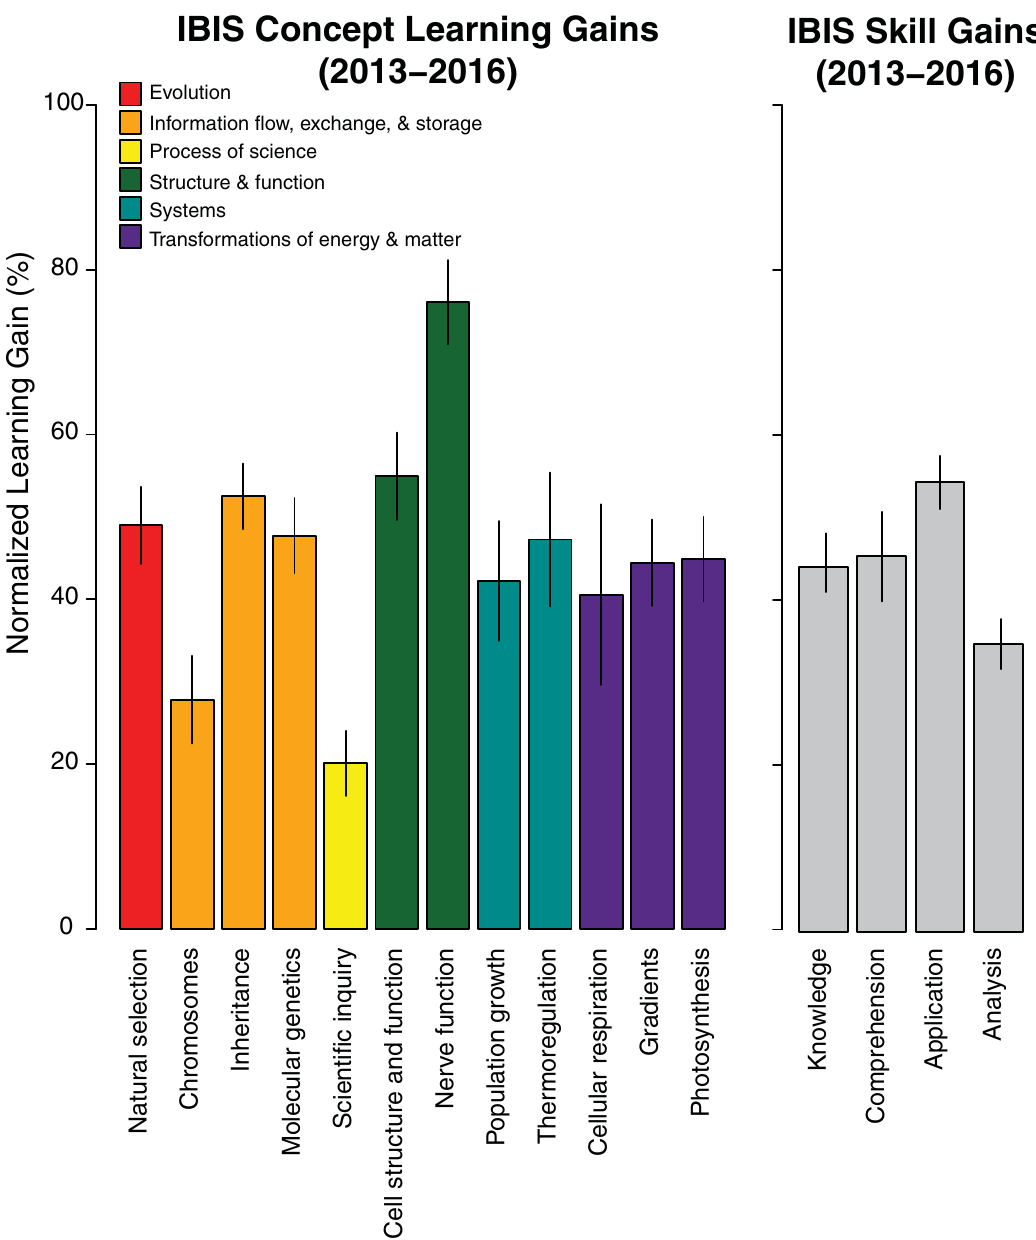
Fig 1. Normalized student learning gains. Normalized learning gains across concepts (a) and skills (b) were above 19%, compiled across all years of the study.